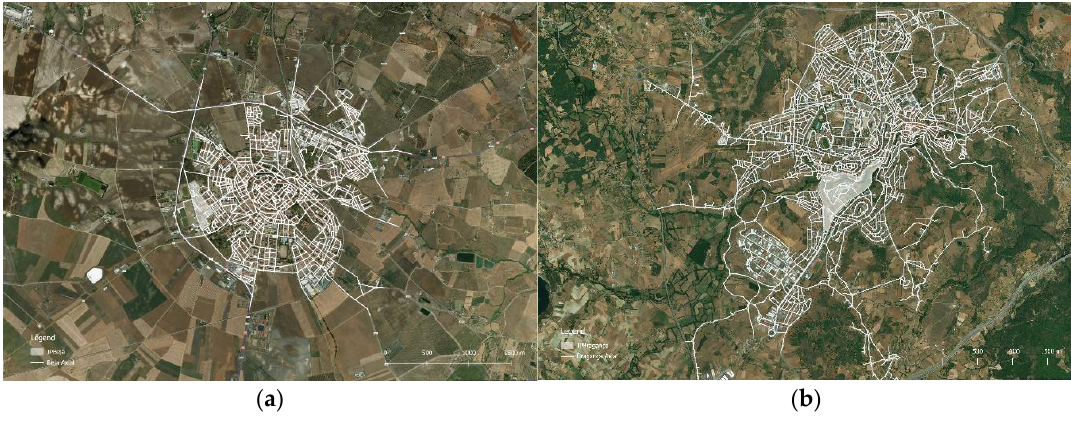
Figure 2. Axial maps: ( a ) Beja; ( b ) Bragança.